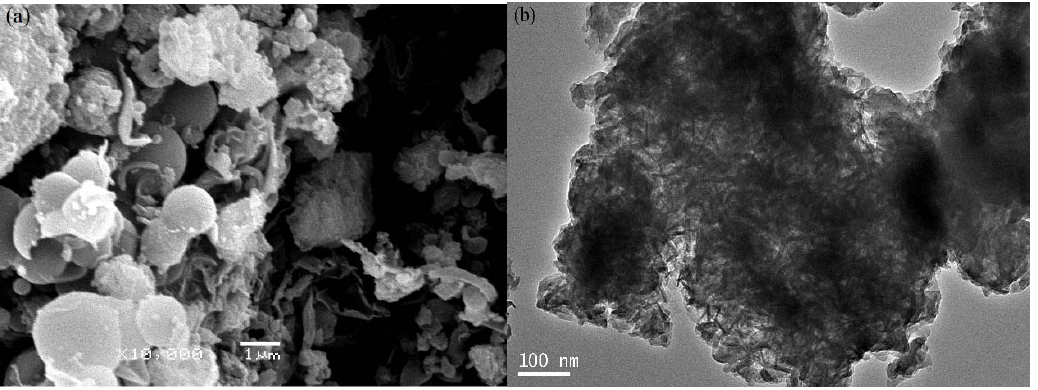
Figure 4. ( a ) SEM and ( b ) TEM images of LDH-[Cu(SO 3